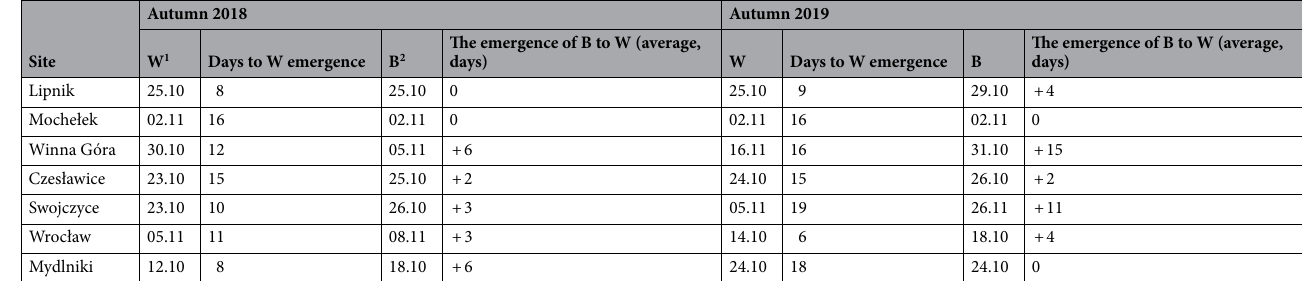
Table 2. Dates of winter wheat and blackgrass emergence, number of days from wheat sowing until emergence, and the emergence of blackgrass to wheat. 1 W winter wheat. 2 B blackgrass.